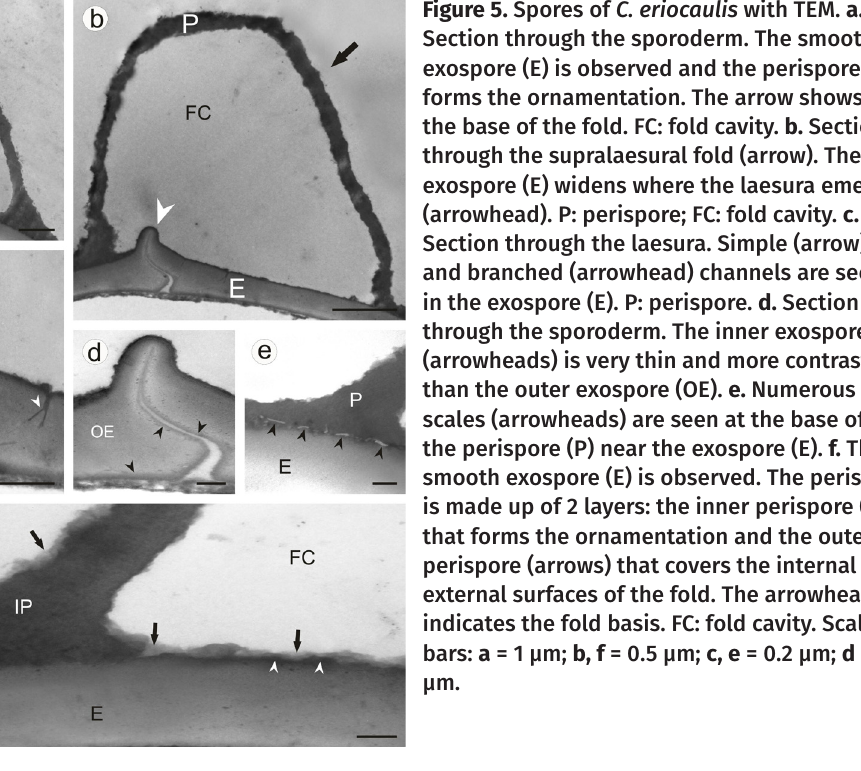
Figure 5. Spores of C. eriocaulis with TEM. a. Section through the sporoderm. The smooth exospore (E) is observed and the perispore (P) forms the ornamentation. The arrow shows the base of the fold. FC: fold cavity. b. Section through the supralaesural fold (arrow). The exospore (E) widens where the laesura emerges (arrowhead). P: perispore; FC: fold cavity. c. Section through the laesura. Simple (arrow) and branched (arrowhead) channels are seen in the exospore (E). P: perispore. d. Section through the sporoderm. The inner exospore (arrowheads) is very thin and more contrasted than the outer exospore (OE). e. Numerous scales (arrowheads) are seen at the base of the perispore (P) near the exospore (E). f. The smooth exospore (E) is observed. The perispore is made up of 2 layers: the inner perispore (IP) that forms the ornamentation and the outer perispore (arrows) that covers the internal and external surfaces of the fold. The arrowheads indicates the fold basis. FC: fold cavity. Scale bars: a = 1 µm; b, f = 0.5 µm; c, e = 0.2 µm; d = 0.1